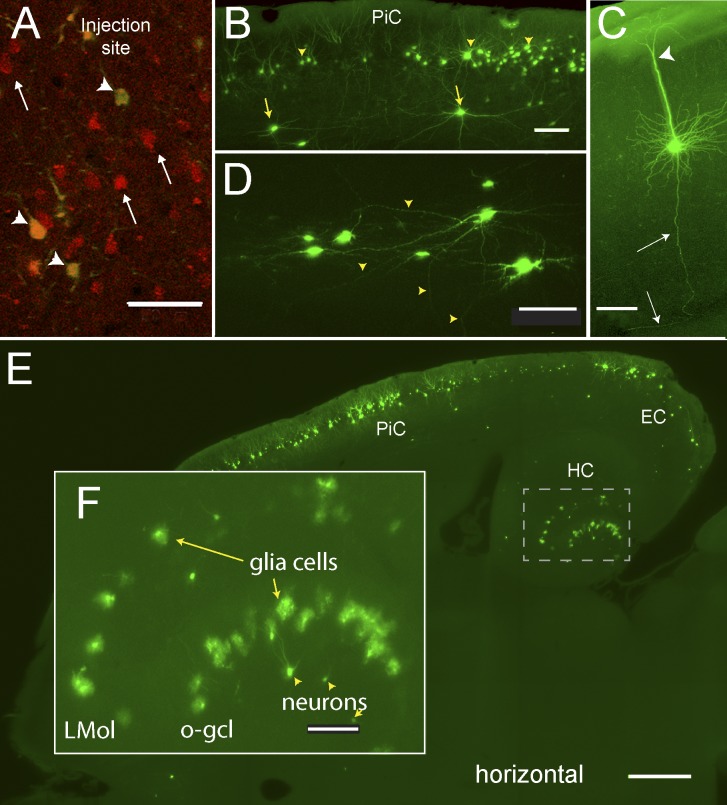
Visualization of cell bodies and neurites in a tB-BABB cleared mouse brain.Brain sample same as Fig 4; original dataset (LSFM recording, horizontal): same as Fig 4, except for (A). (A) Confocal recording (single plane) from EC layer 3 near the injection site taken after 271 days in clearing solution. Overlay of red channel (rAAV-driven mRFP1 fluorescence, arrows) and green channel (RABVΔG-EGFP fluorescence). Double-infected cells expressing rAAV-driven mRFP1 plus RABVΔG-EGFP fluorescence are indicated by orange to green color (arrowheads). Recording direction: from brain surface (positioned perpendicular to optical axis) to interior. Scale bar, 100 μm. (B) LSFM 50 μm z range maximum projection from a subvolume of the PiC area (RABVΔG-EGFP fluorescence). Arrowheads indicate some Layer 2 neurons, arrows some interneurons. Scale bar, 100 μm. (C) LSFM 50 μm z range maximum z projection from a subvolume of the auditory cortex region (RABVΔG-EGFP fluorescence) showing a cortical layer 5 cell with a big apical dendrite (arrowheads), basal dendrites at the soma, and a basal axon (long arrows). Scale bar, 100 μm. (D) LSFM 90 μm z range maximum projection from a subvolume of the septal area (RABVΔG-EGFP fluorescence) 2.3 mm below brain surface revealing neurite structures (arrowheads). Scale bar, 100 μm. (E) LSFM 20 μm z range maximum projection (RABVΔG-EGFP fluorescence) from a subvolume of the PiC/EC/HC region, showing neurons from cortical EC and the PiC regions and glia from the HC region projecting to the injected EC neurons. Scale bar, 500 μm. (F) Hippocampal DG area enlarged from (E), showing glia cells in the outer granule cell layer (o-gcl) and stratum lacunosum moleculare (LMol), and neurons in the DG hilus region (arrowheads). PiC, Piriform cortex; EC, Entorhinal cortex. Scale bar, 100 μm.